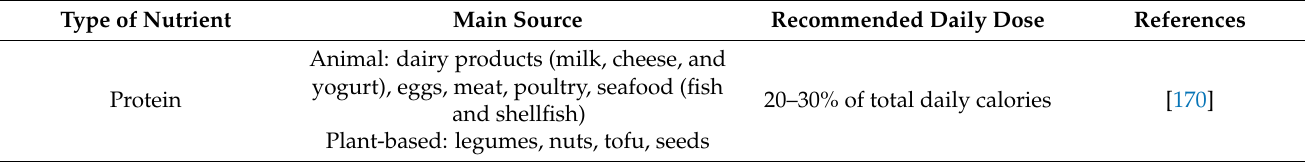
Table 3. Recommendations regarding dietary proteins for patients with T2DM. Type of Nutrient Main Source Recommended Daily